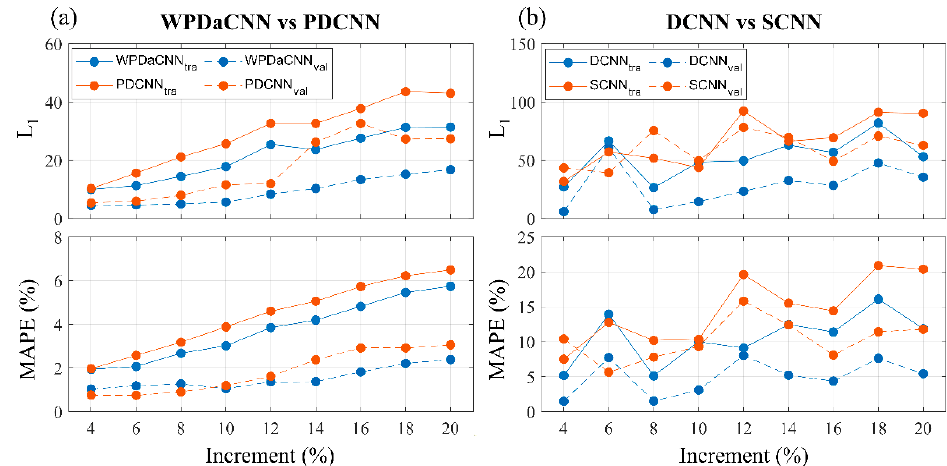
Figure 5. Performance of pyramid models trained under different dictionary increments. The solid line is the model prediction by training data, and the dashed line is that of the testing data. ( a ) L 1 and MAPE of the WPDaCNN and PDCNN models. ( b ) L 1 and MAPE of the DCNN and SCNN models.